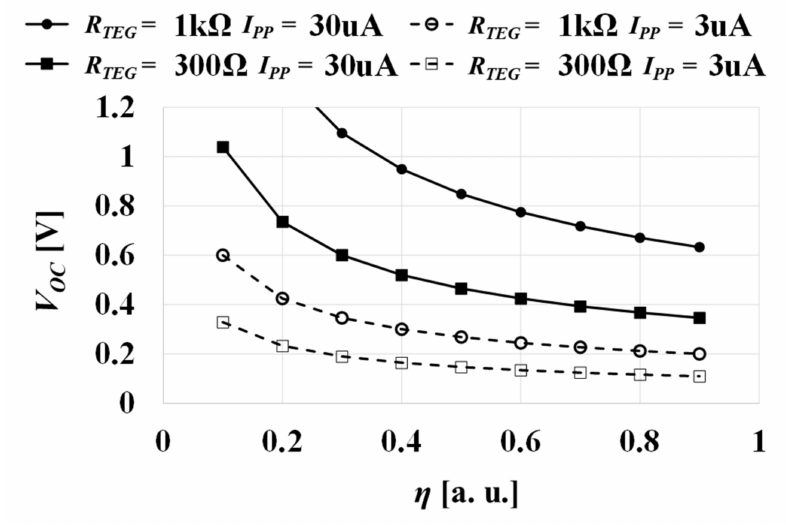
Figure 5. V OC vs. η with I PP = 30 µ A or 3 µ A and R TEG = 300 Ω or 1 k Ω at V PP = 3